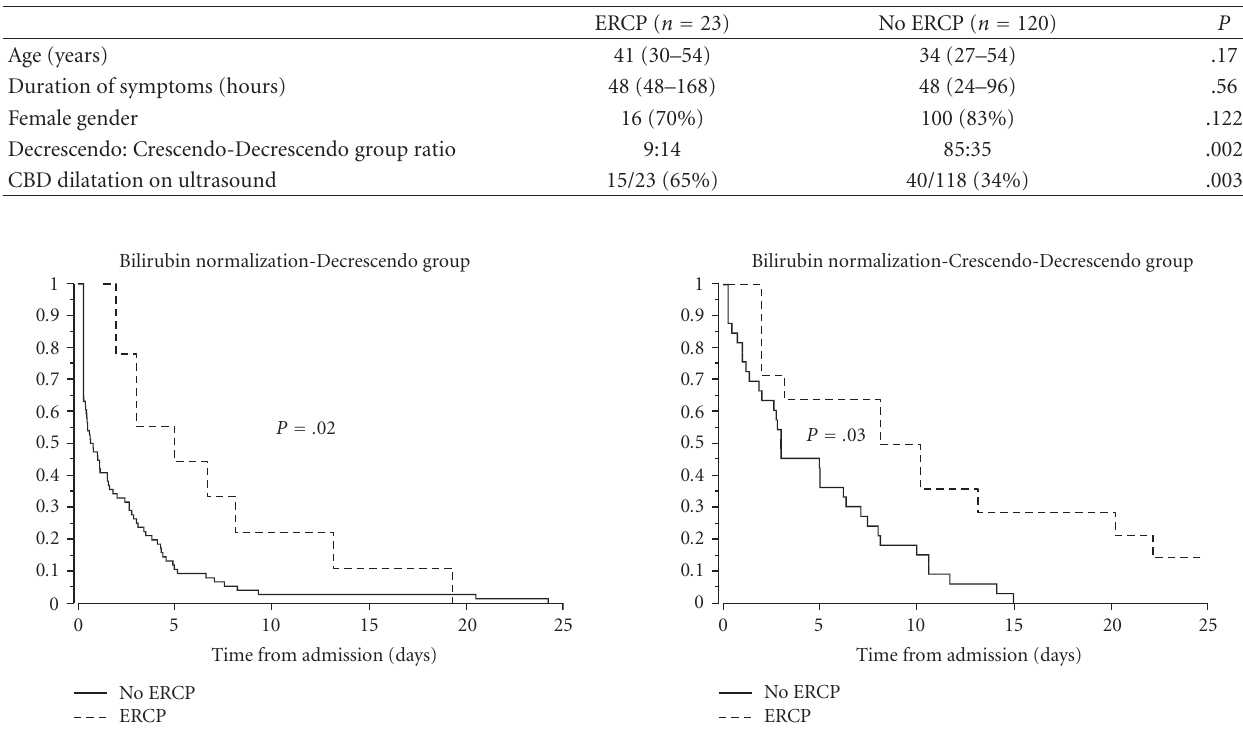
Figure 3: Kaplan Meier plot of Time to Normalization ( < 1.0mg/dL) of bilirubin in the Decrescendo group. In patients not undergoing ERCP, time 0 was the time of admission which corresponded to the highest bilirubin level for that patient. In patients undergoing ERCP, time 0 was the day of the ERCP and time to normalization was calculated from the time of ERCP. Time to normalization in patients undergoing ERCP was significantly delayed ( P = . 02).